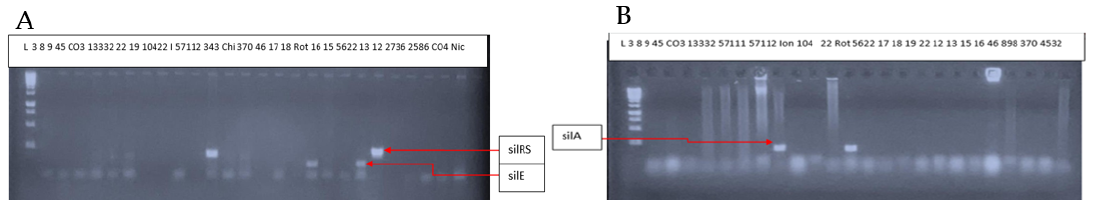
Figure 6. Electropherogram of amplicons obtained by PCR for SilCAB and SilF genes. ( A ) Wells 2–25—amplicons of the analyzed strains; well no. 1, L-Molecular weight marker GeneRuler 10,000 bp (Thermo-Scientific, Waltham, MA, USA); Positive strains for the SilCAB gene: number 46— S. xylosus ; 55751—MRSA. ( B ) Wells 2–24—amplicons of the analyzed strains; well no. 1, L-Molecular Weight Marker GeneRuler 10,000 bp (ThermoScientific); Positive strains for SilF gene: number 14532— S. xylosus ; 5622— E. coli .